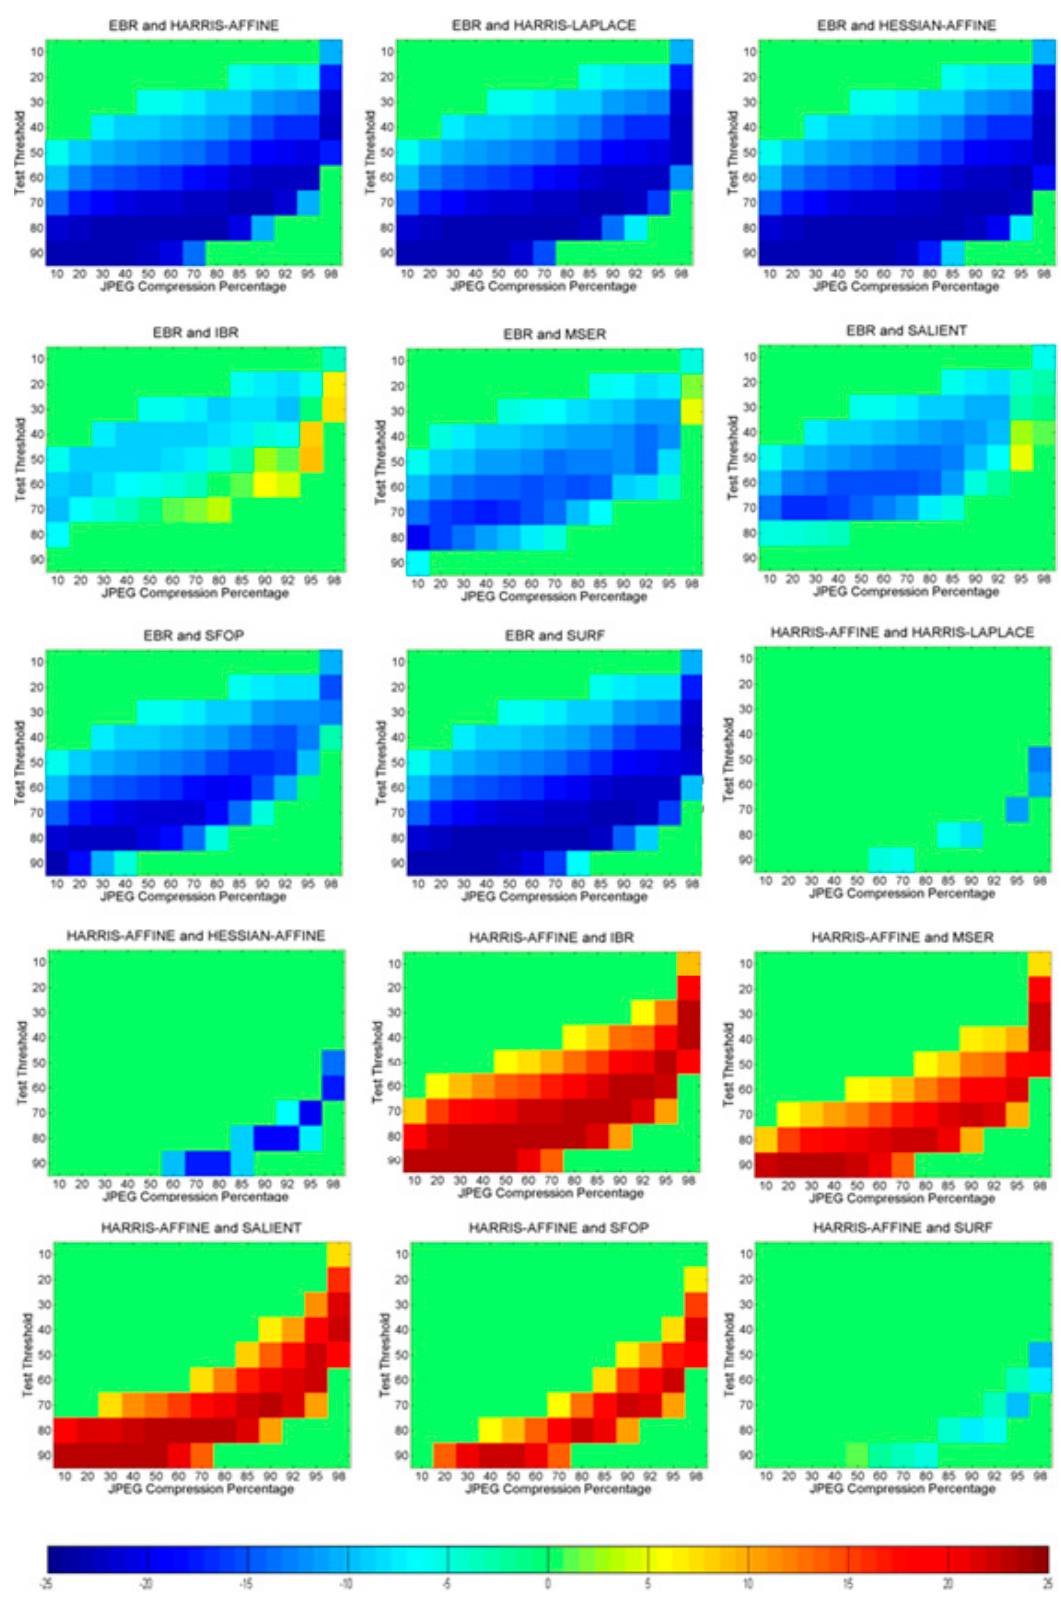
Figure 10. JPEG compression results for EBR and Harris-Affine with the other detectors showing Z -scores obtained; positive Z -scores indicate that the first detector is better than the second whereas the negative values show the converse.